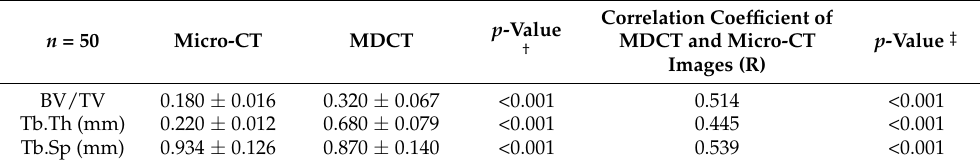
Table 5. Trabecular bone structure parameters and correlation coefficients (R) of micro-CT and MDCT